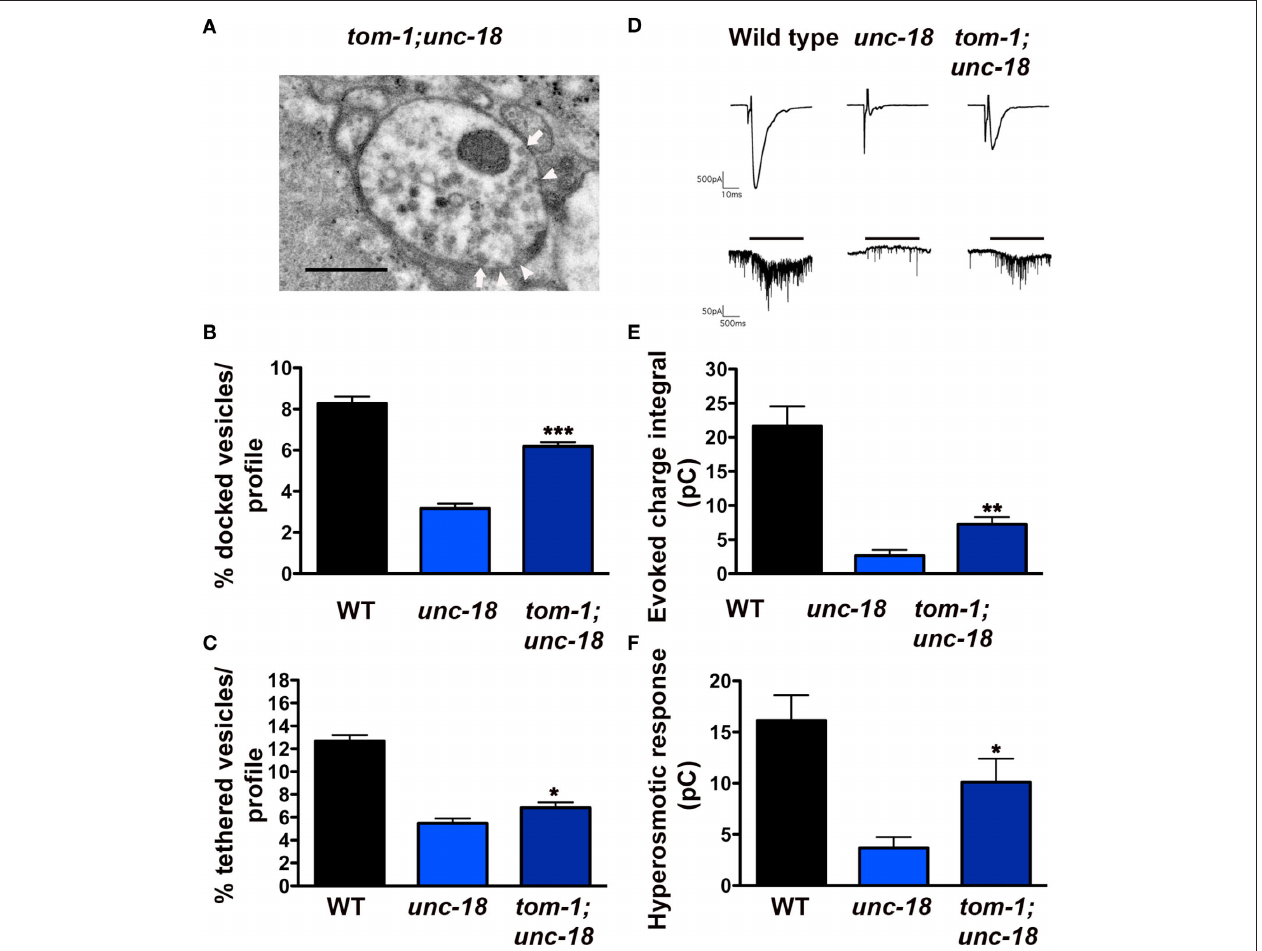
FigUre 7 | tom-1 mutants partially rescue synaptic function in unc-18 mutants due to an increase in the docked, fusion competent synaptic vesicle pool. (A) Representative electron micrograph of an NMJ profile from a tom-1(ok285);unc-18(b403) double mutant. Arrowheads indicate plasma membrane docked synaptic vesicles, arrows indicate tethered synaptic vesicles ( < 25 nm of the plasma membrane), PD presynaptic density, scale bar 300 nm. Average docked (B) and tethered (C) synaptic vesicles expressed as a percentage of total vesicles per synaptic profile for wild-type ( n = 178 synaptic profiles, vesicle density 20.2 ± 0.6), unc-18(b403) ( n = 60 synaptic profiles,